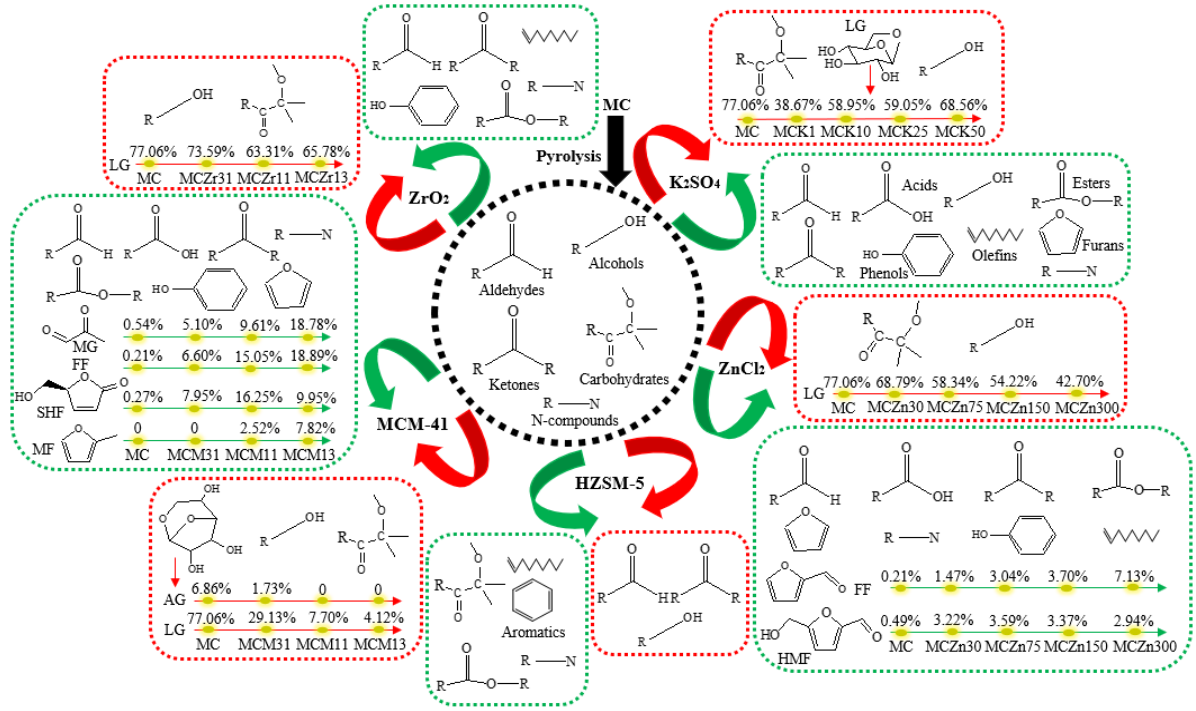
Figure 7. Effects of five catalysts on the distribution of MC pyrolysis products (green and red represent promotional and inhibitory effects, respectively) (LG, Levoglucosan; MG, Methylglyoxal; FF, Furfural; SHF, (S)-5-Hydroxymethyl-2[5 H]-furanone; MF, 2-Methylfuran; AG, 1,6-Anhydro- β -D- glucofuranose; HMF, 5-Hydroxymethylfurfural).